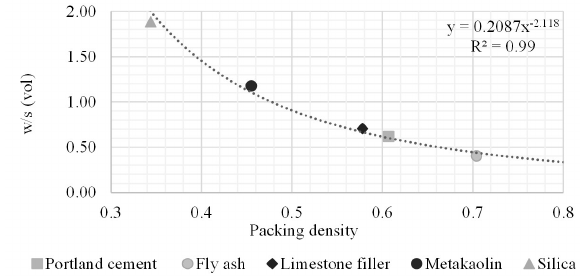
Figure 10. Packing density and water demand correlation from the mixing energy